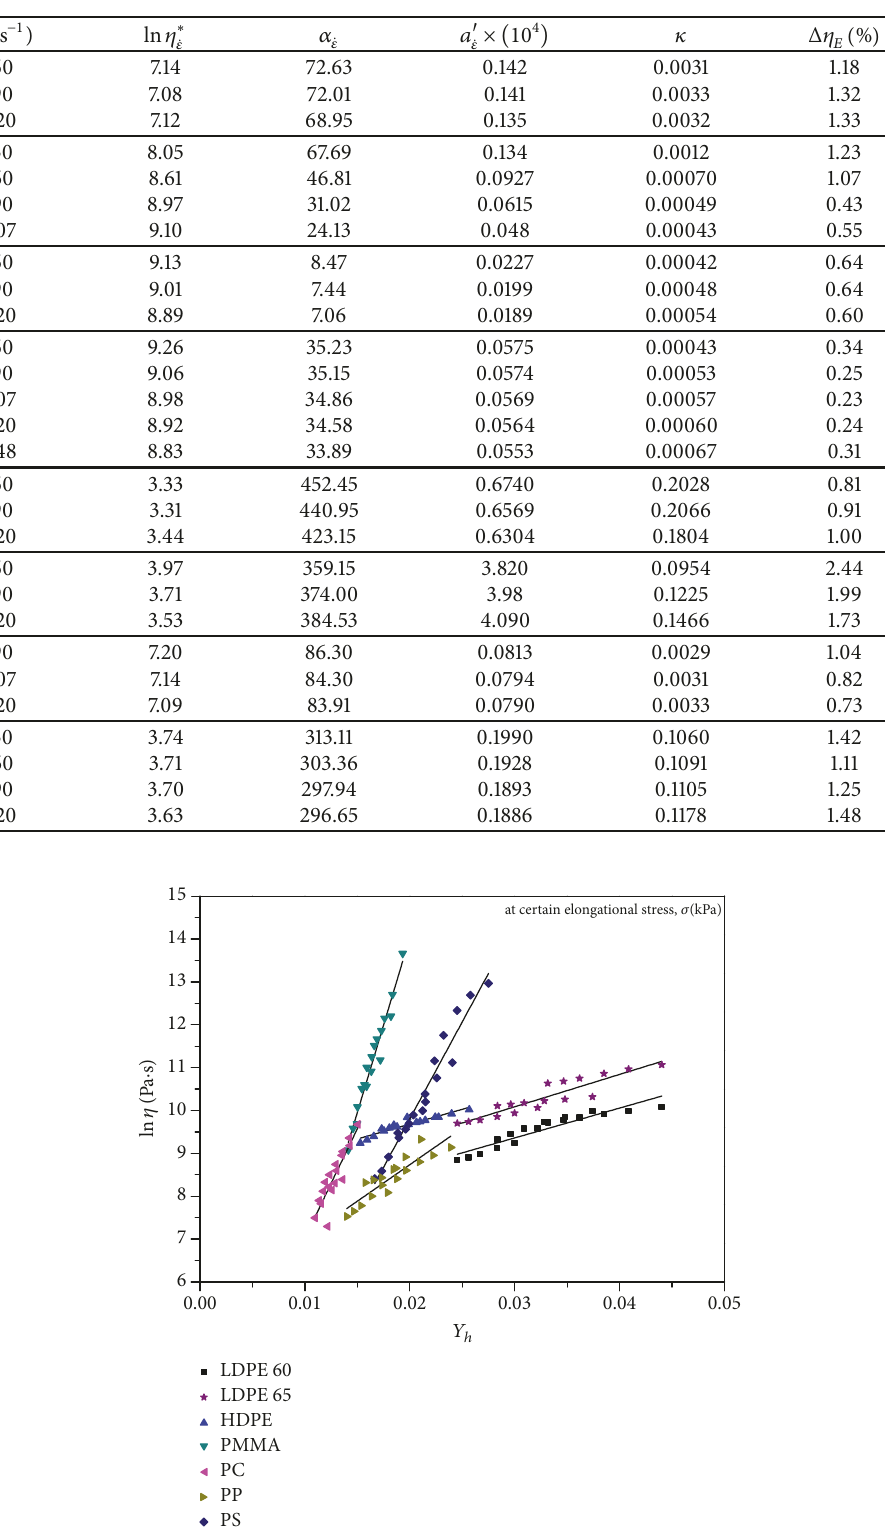
Figure 6: The logarithm of viscosity at certain elongational stress (the elongational stresses used in the figure indicated with italic font in Table 4) versus 𝑌 ℎ . The solid line is the best fit line through each data set by (7) and (8) with the parameters tabulated in Table